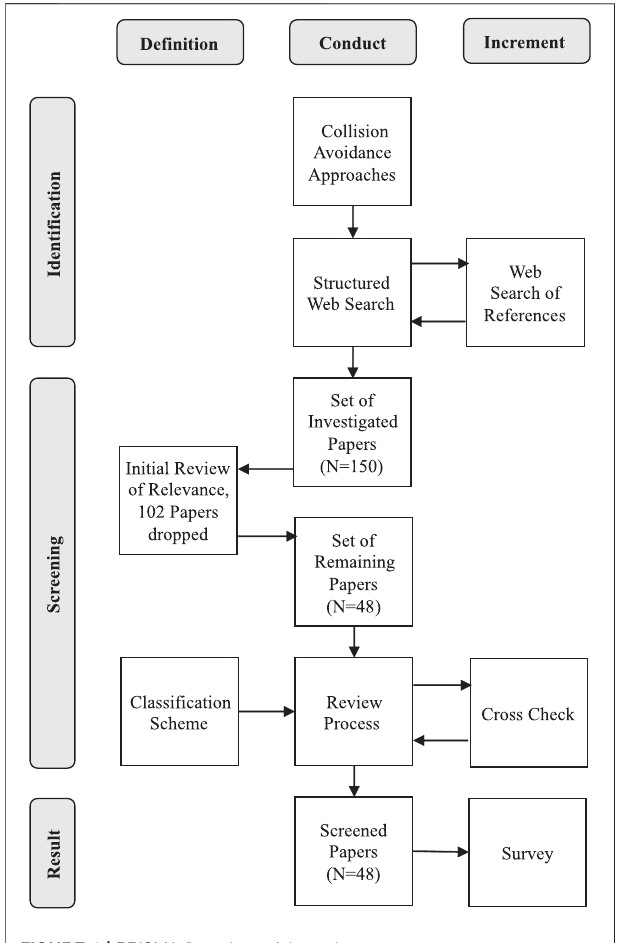
FIGURE 1 | PRISMA fl ow chart of the review